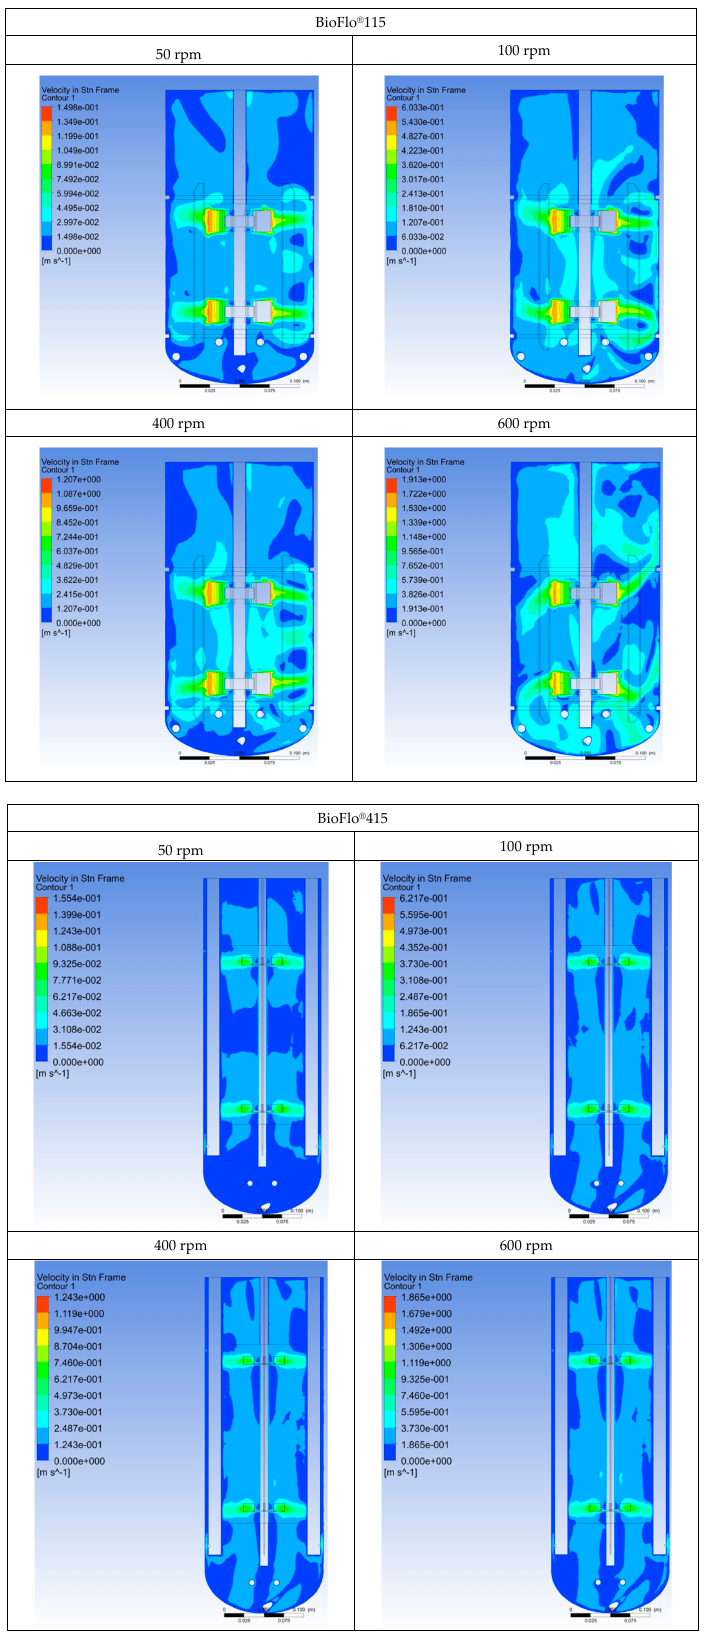
Figure 3. Typical simulated results of velocity profiles for the tested mixing systems.